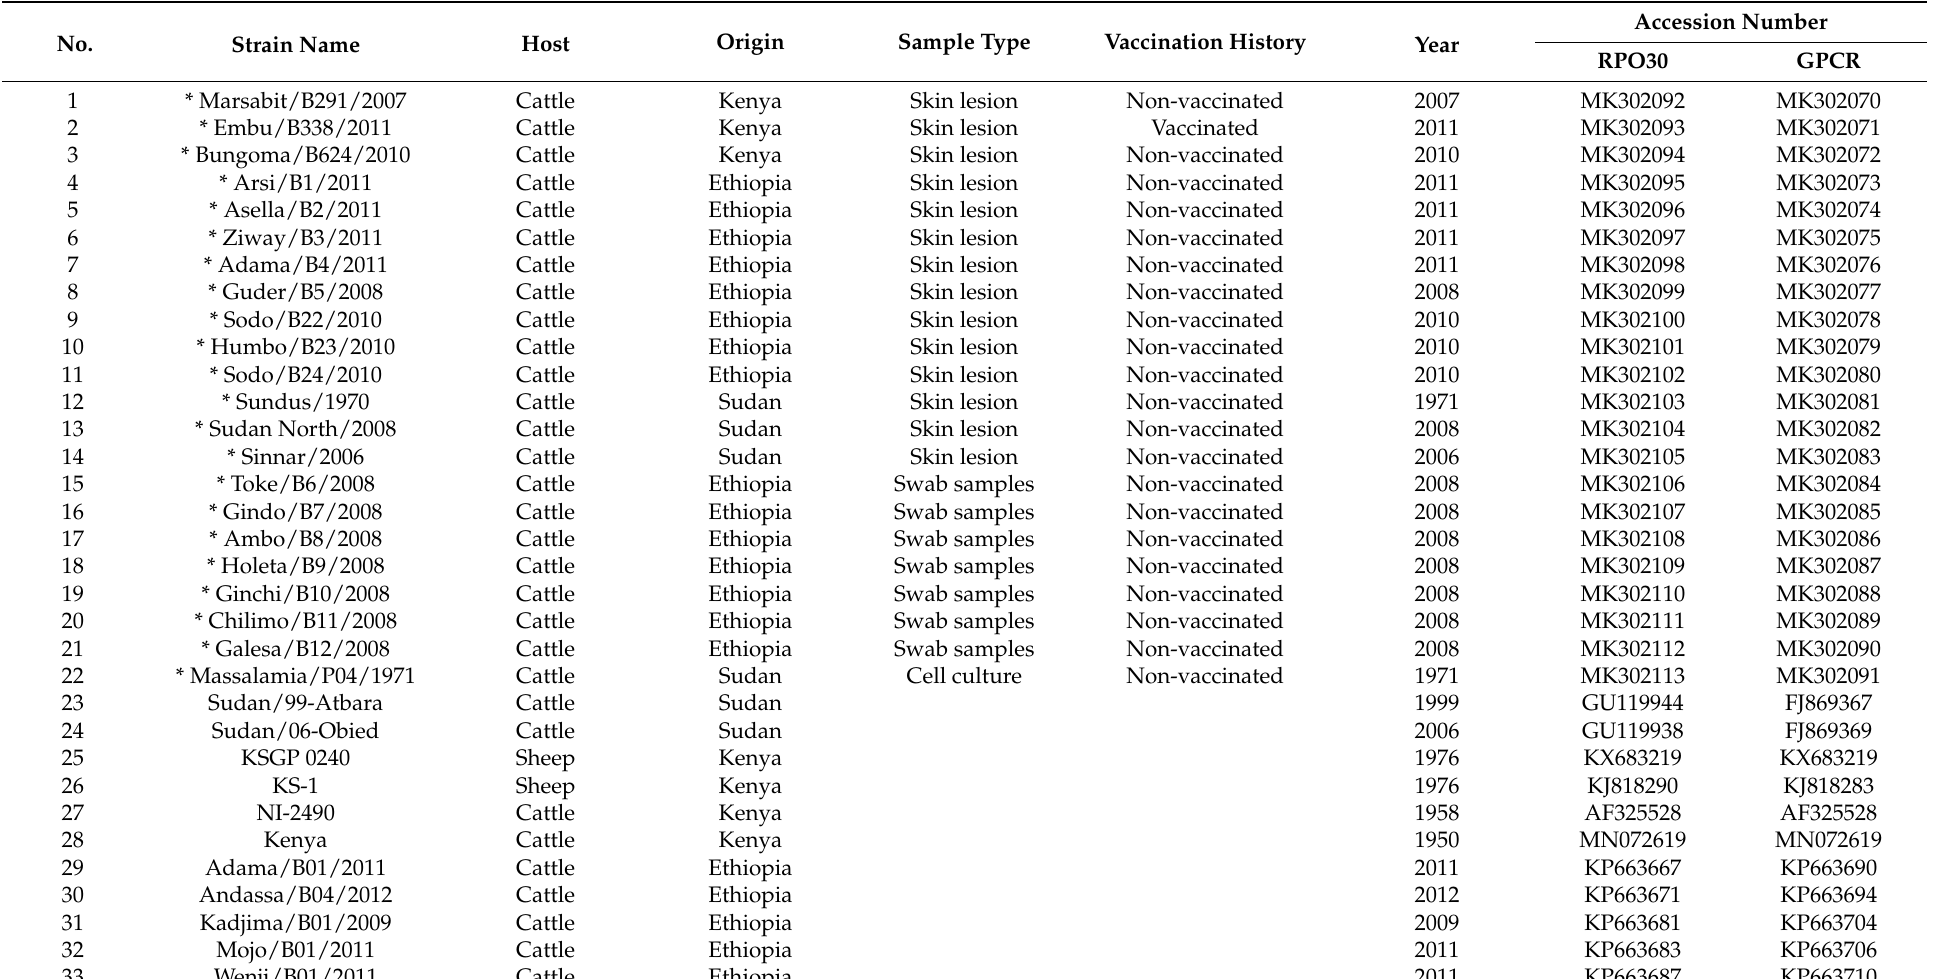
Table 1. LSDV isolates from East Africa included in this study and previous